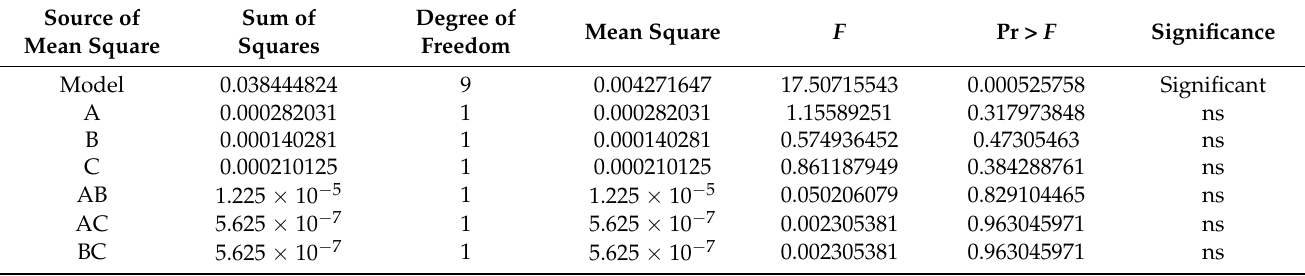
Table 3. GABA production regression analysis using the Box-Behnken DTD experimental